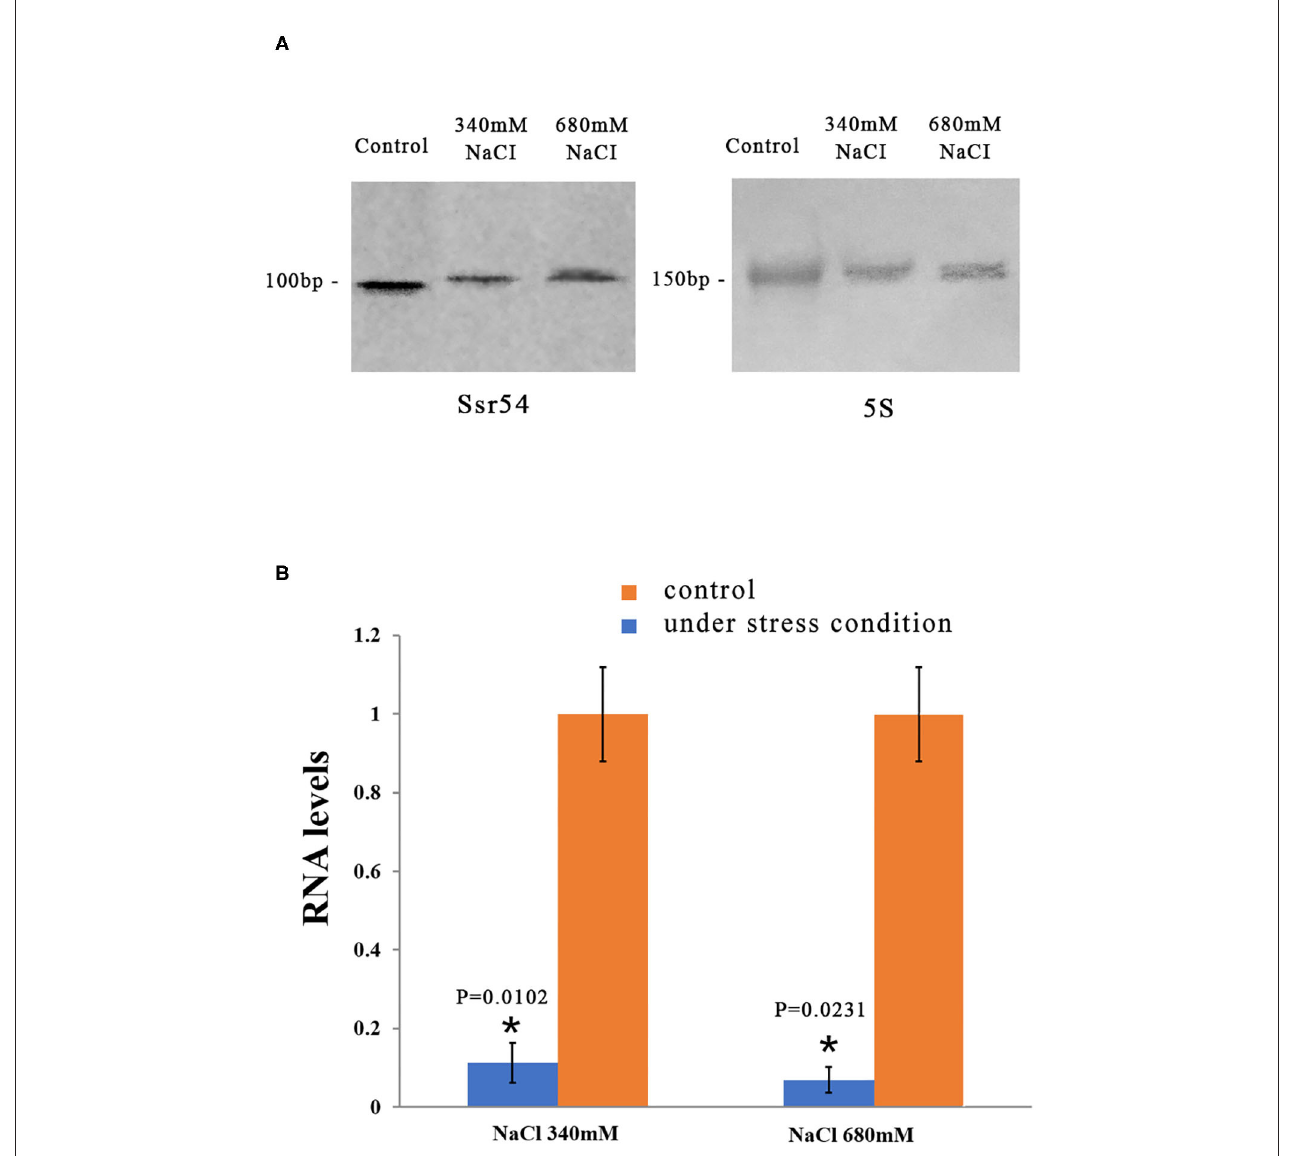
FIGURE 2 | Levels of the small RNA Ssr54 in S. flexneri strain 301 when exposed to high osmotic conditions for 30min. (A) Northern blot of Ssr54 and 5S rRNA in the S. flexneri wild-type strain under hyperosmotic conditions. Control cultured in 160mM NaCl; (B) RNA levels of Ssr54 , qRT-PCR analyses of the relative Ssr54 levels in S. flexneri under high osmotic conditions compared with that in 160mM NaCl. Relative abundance was calculated using the 2 − 11 Ct method. Bars indicate fold changes calculated as the mean of triplicate experiments, representing the ratios of Ssr54 expression levels. Black bars represent the control transcript values; Red bars represent results under stress conditions. Error bars indicate standard deviations. Statistical analyses were performed using Student’s t